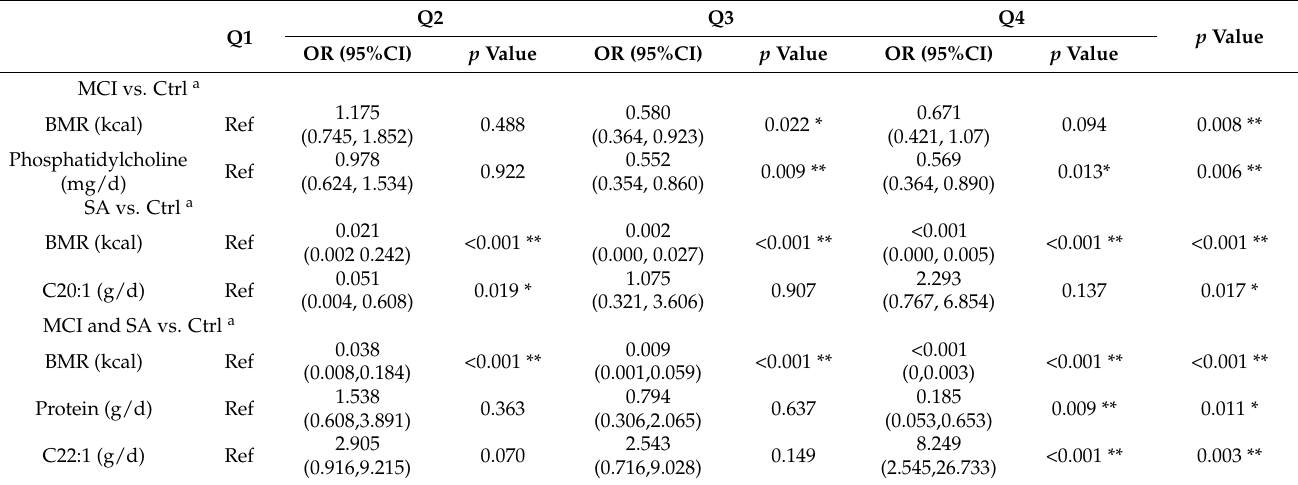
Table 3. Multivariate logistic regression analyses for three